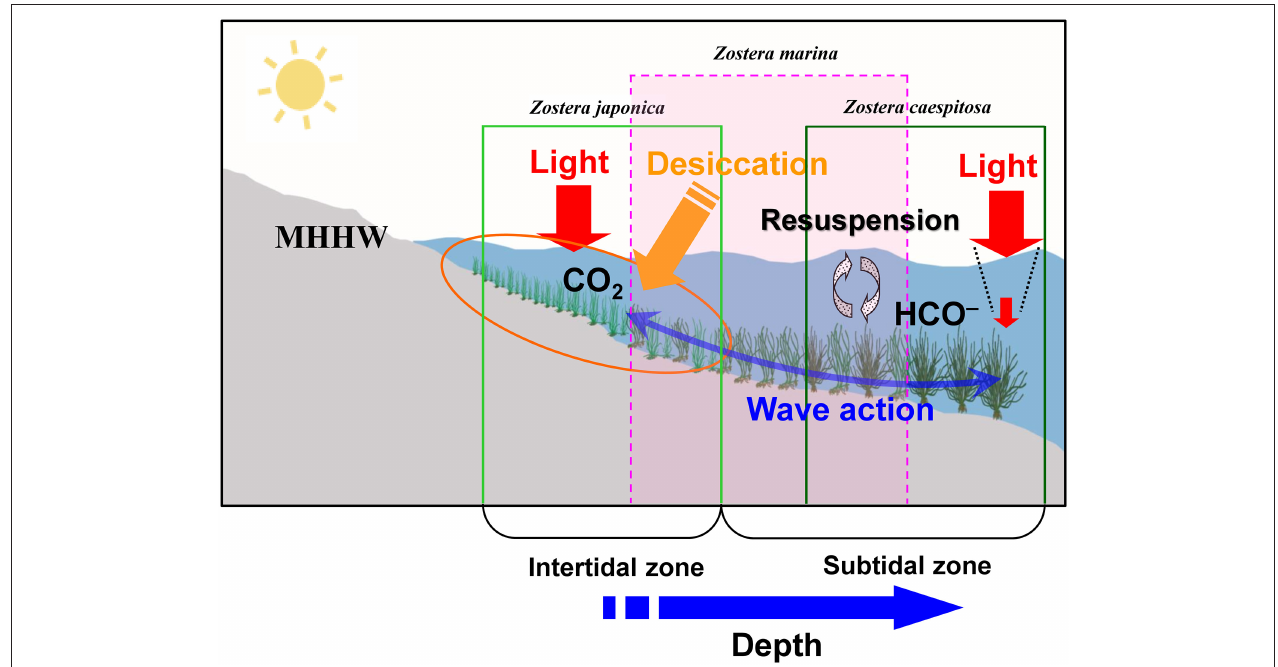
FIGURE 1 | Diagrams of three Zostera species ( Z. japonica , Z. marina , and Z. caespitosa ) zonation patterns and key features of environmental factors affected seagrass beds in Koje Bay along the southern coast of Korea. MHHW indicates Mean Higher High